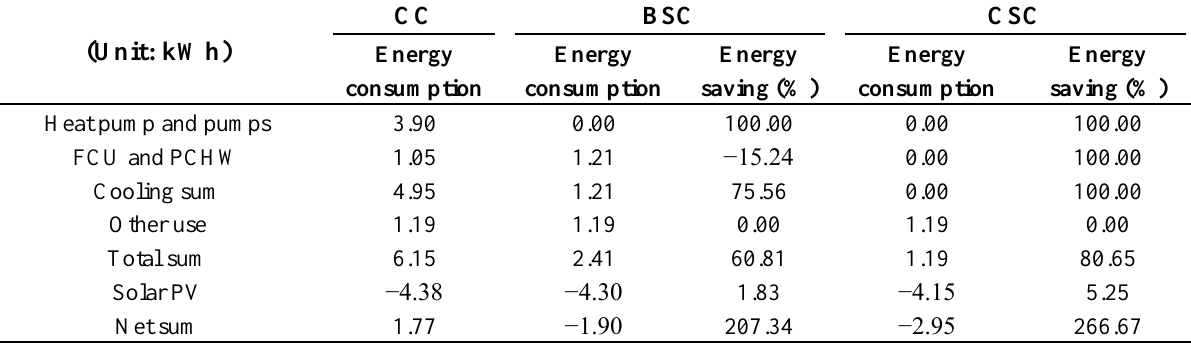
Figure 9. Energy consumption for different control strategies ( a ) CC; ( b ) BSC; and ( c ) CSC in space-cooling operation mode tests. Table 3. Electricity consumption during on-peak period with three different control strategies for space-cooling-mode